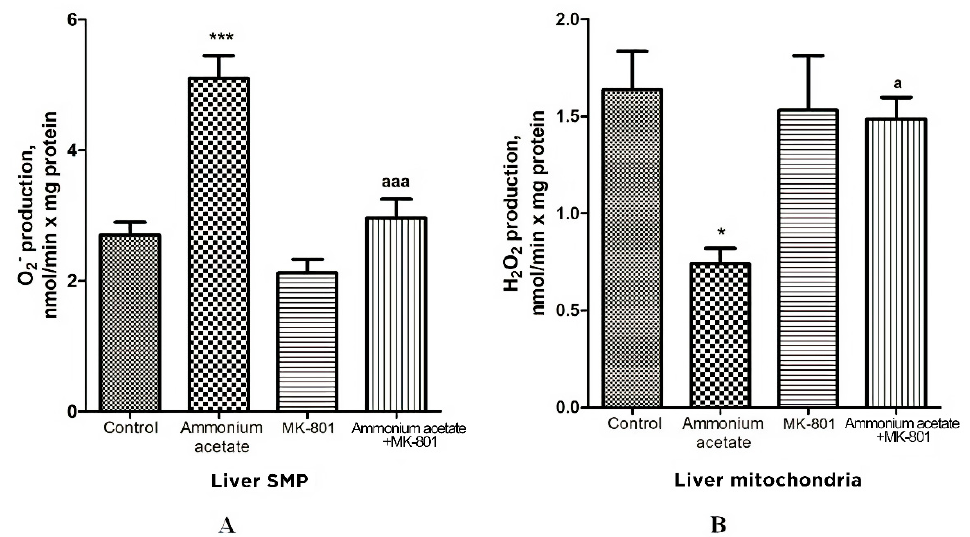
Figure 5. Effects of injection of ammonium acetate and/or MK-801 on O 2 •− ( A ) and H 2 O 2 ( B ) production by liver SMP and mitochondria. Experimental design was the same as in Figure 1 legend. The rates of O 2• − and H 2 O 2 formation were determined as indicated in Materials and Methods. All data are shown as mean ± SEM. Values significantly different from the control group are designated with one (*) and three (***) asterisks: * p < 0.05, *** p < 0.001 (Student’s t -test). a significant differences, compared with ammonia group. a p < 0.05, aaa p < 0.001 (with the Bonferroni correction for multiple comparisons).